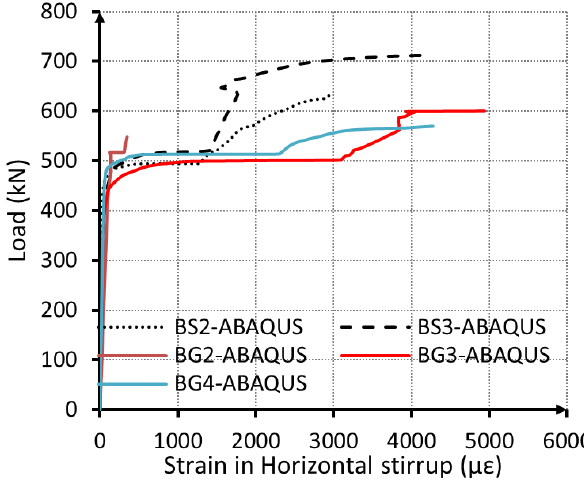
Figure 36: Strain curve of horizontal web reinforcement for deep